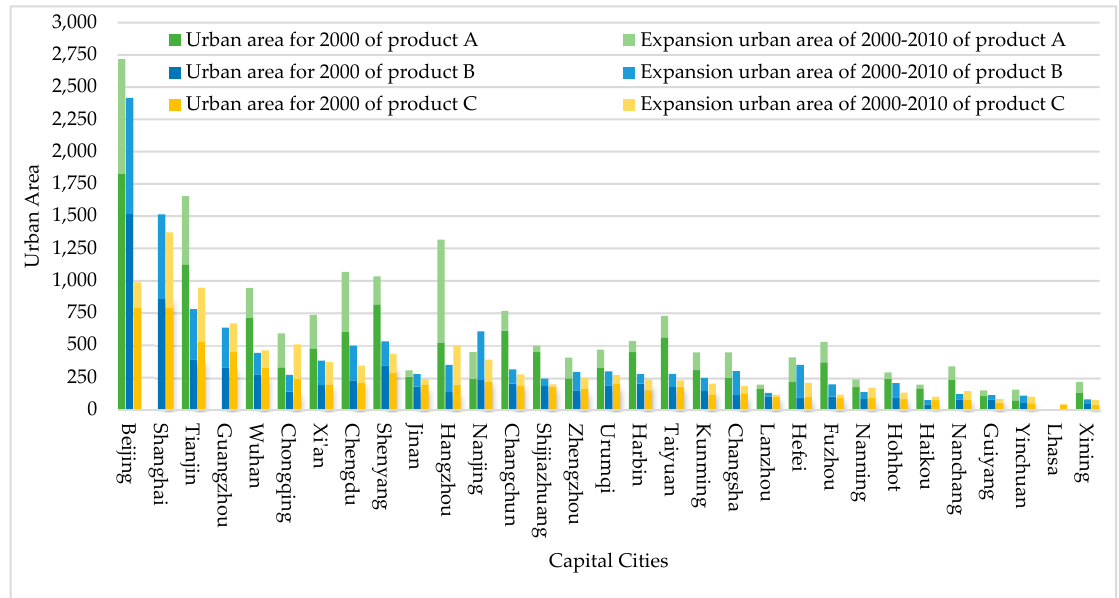
Figure5. Thecomparisonofextractionresultsofurbanareas. Figure 5. The comparison of extraction results of urban areas. Product C is the result of proposed method.